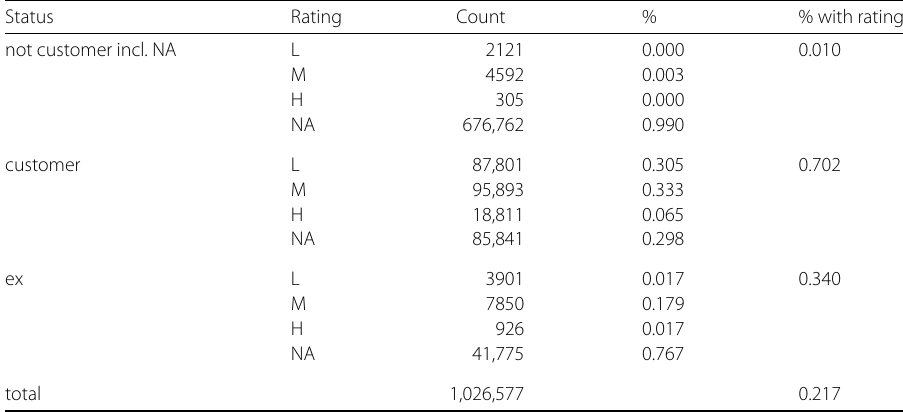
Table 3 Average monthly distribution of nodes by customer status and rating Status Rating Count % % with rating not customer incl. NA L